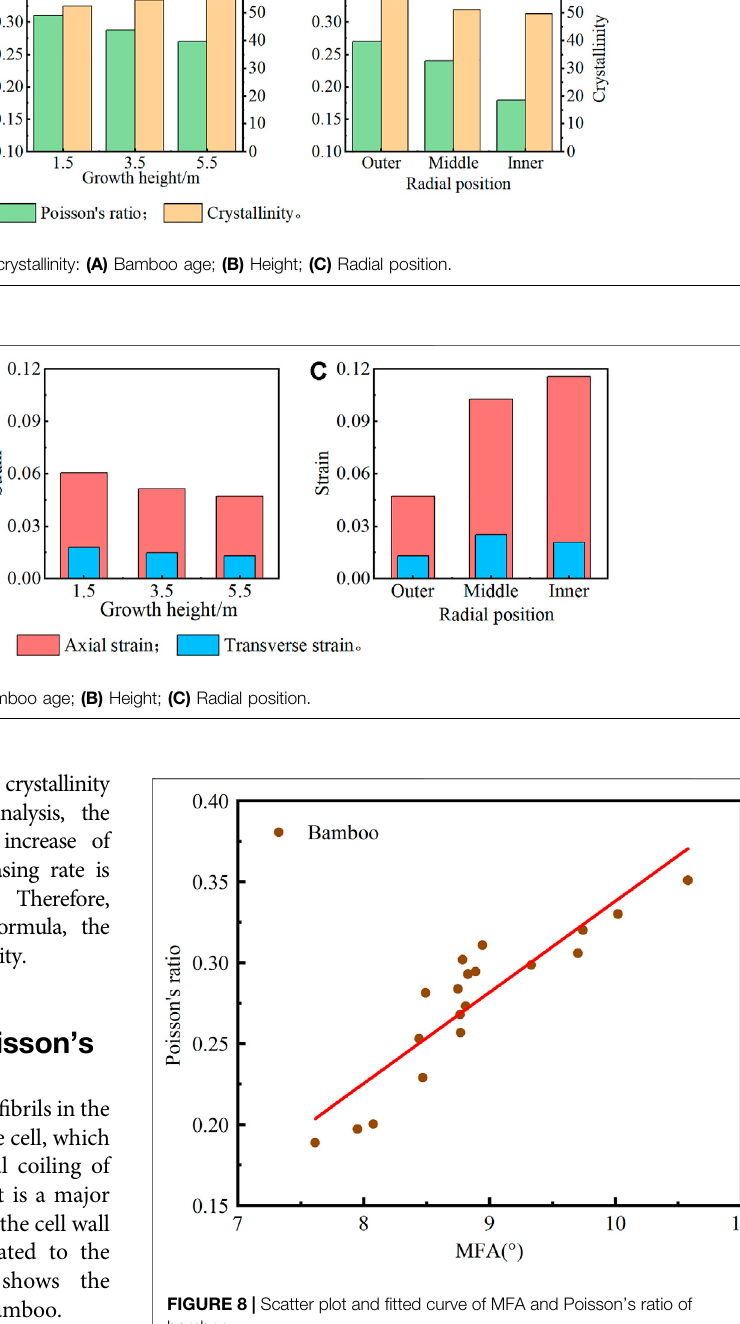
FIGURE 8 | Scatter plot and fi tted curve of MFA and Poisson ’ s ratio of